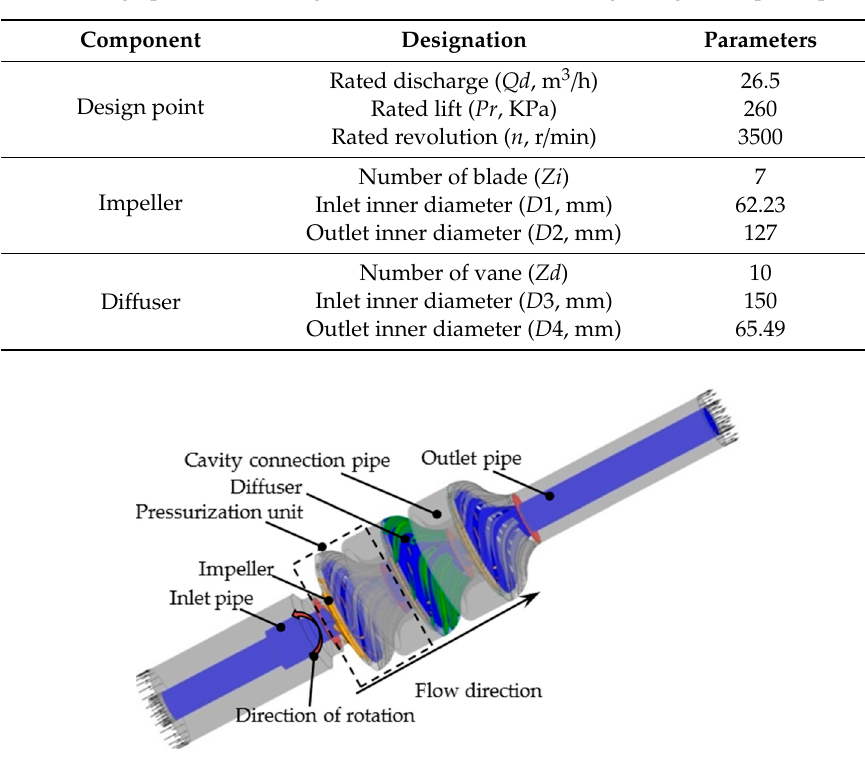
Table 1. Design parameters and geometric dimensions of a single-stage multiphase pump.